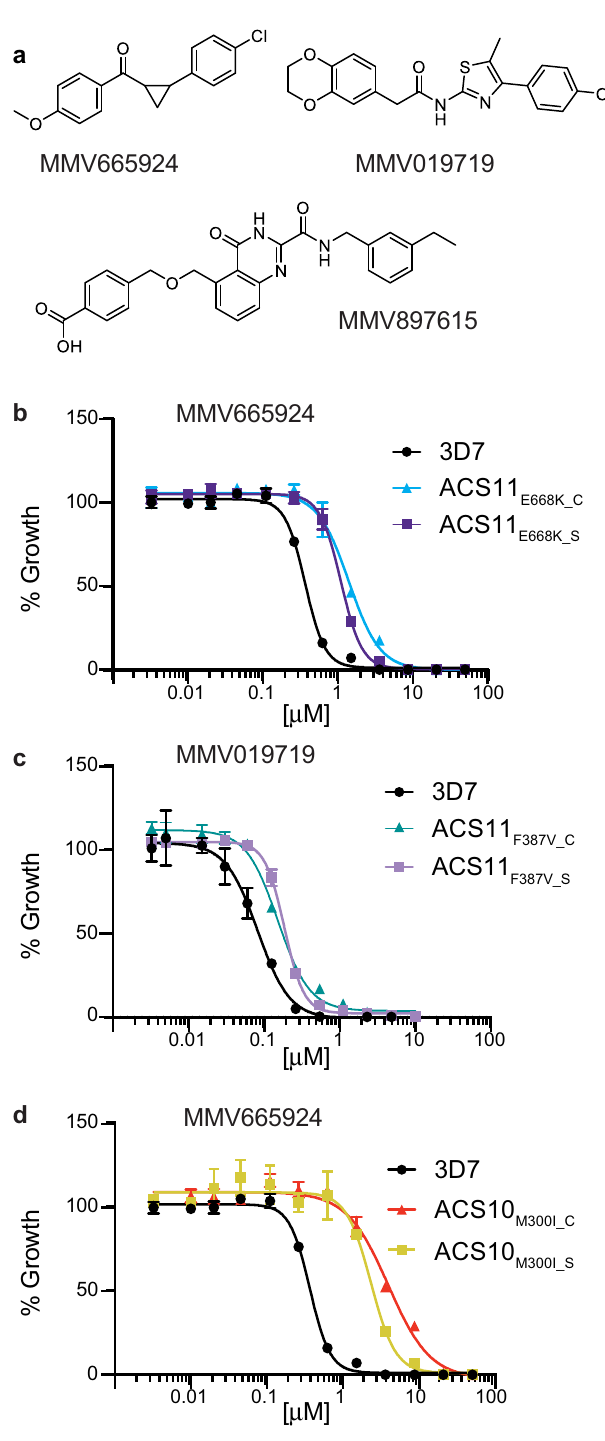
Fig. 1 | Gene-edited Pf ACS10 and Pf ACS11 lines phenocopy parasite lines selected to become resistant to a range of antiplasmodial chemotypes. a Chemical structures of the compounds used in drug selections. b – d Dose response curvesforarepresentativeexampleoftheparental3D7line(black),theselectedlines (ACS11 E668K_S , ACS11 F387V_S , and ACS10 M300I_S ) and the genetically edited lines (ACS11 E668K_C ,ACS11 F387V_C ,andACS10 M300I_C )againstthecompoundusedtoselectfor the resistant lines. At least three biological replicates were run for each strain in technicaltriplicates.Shownaretheaverage±SDandthenon-linearregressioncurve fi t for one biological assay run in triplicate. Statistical signi fi cances for EC 50 are reported in Supplementary Data 1 and source data are provided as a Source Data fi